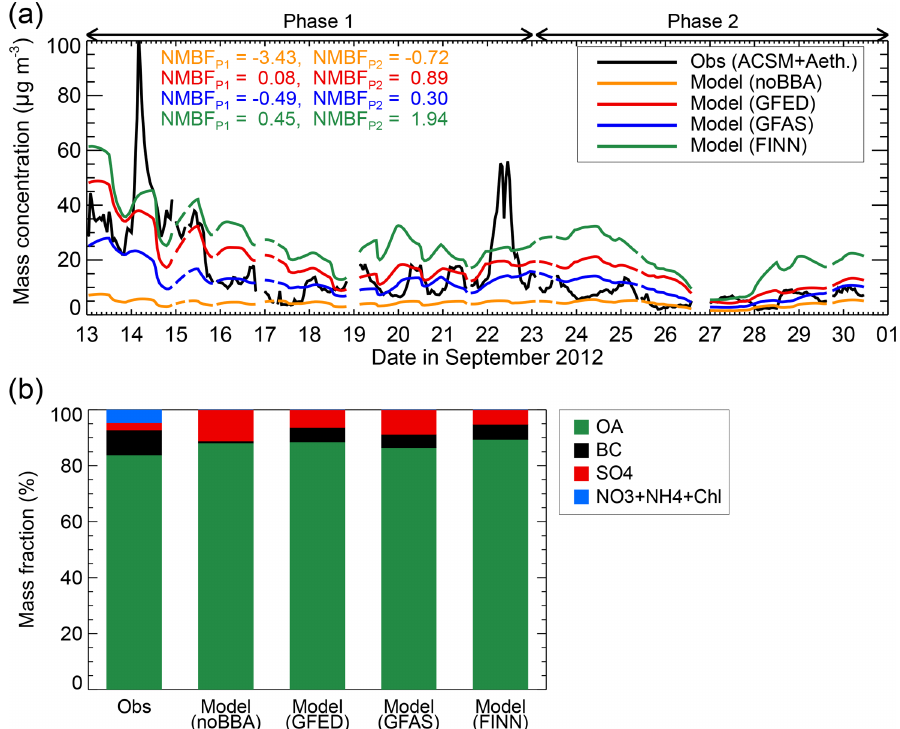
Figure 4. Composition-resolved aerosol mass at Porto Velho ground station during the SAMBBA campaign. (a) Time series of hourly mean observed (black) and simulated (colour) total aerosol mass. The observed aerosol mass is the total mass from the ACSM plus equivalent BC from the aethalometer. Simulated total aerosol mass is shown for the model with FINN1.5 (green), GFAS1.2 (blue), GFED4 (red) emissions and with no biomass burning emissions (noBBA; orange). Numbers on the panel show the NMBF for the SAMBBA campaign separately for Phase 1 (P1) and Phase 2 (P2) (also see Table 2). (b) Bar chart showing observed and simulated average aerosol composition during the campaign: black carbon (BC; black), nitrate + ammonium + chloride (NO 3 + NH 4 + Chl; blue, not treated by the model), organic aerosol (OA; green) and sulfate (SO 4 ;